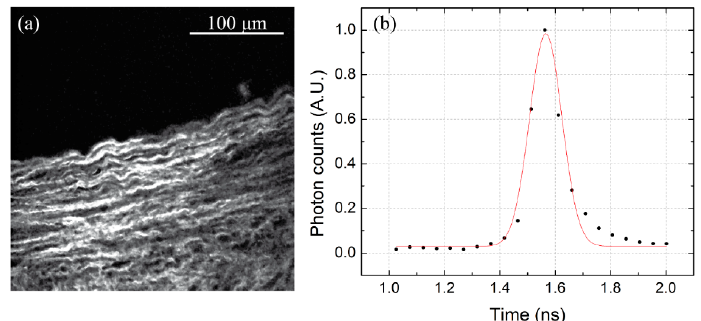
Figure 6. ( a ) SHG image of a collagen sample. ( b ) The corresponding time-resolved signal with a superimposed Gaussian fit.